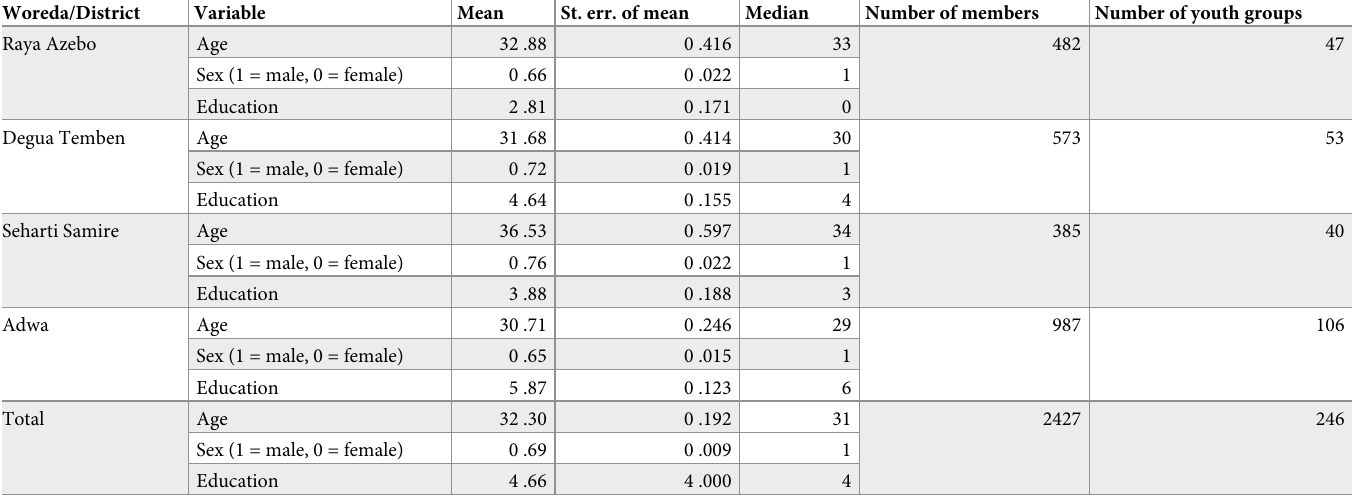
Table 1. Demographic characteristics of sample youth group members by